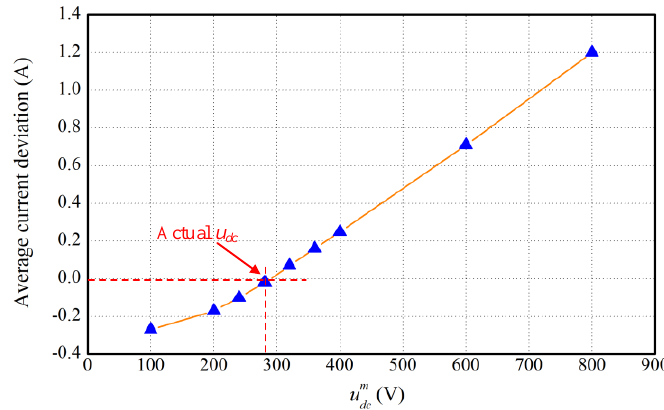
u dc in steady-state operation.